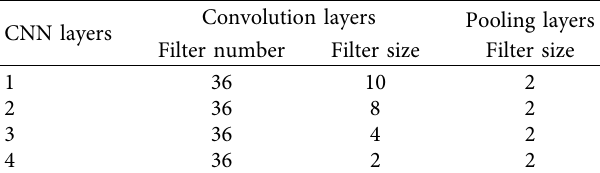
Table 3: Configurations of the DCNN